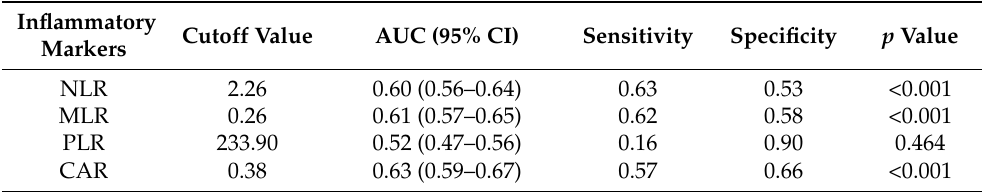
Table 5. Optimal cutoff values of the preoperative inflammatory markers for discriminating between the POD and non-POD